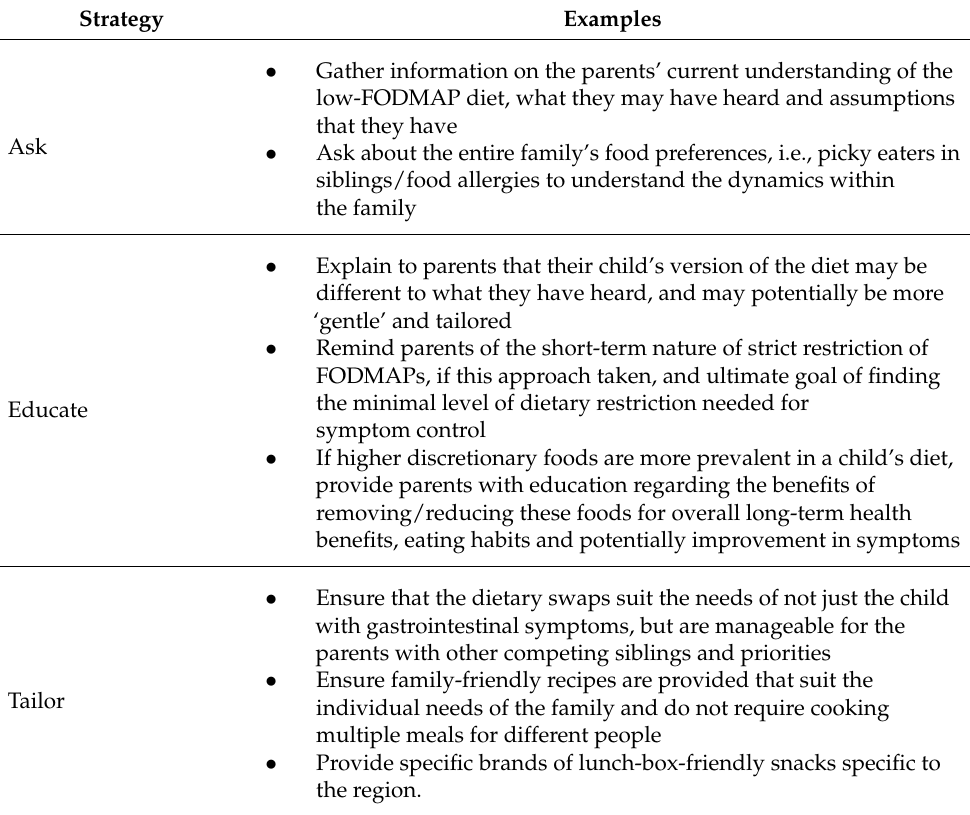
Table 2. Practical ways of keeping parents engaged when their child is prescribed a low- FODMAP